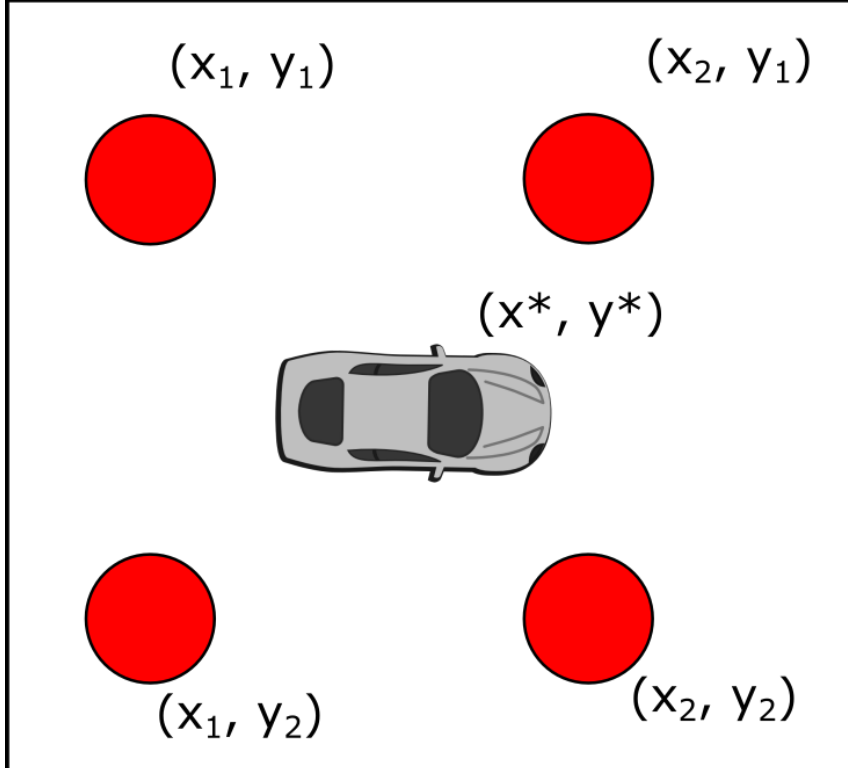
Figure 3. Points used for the interpolation